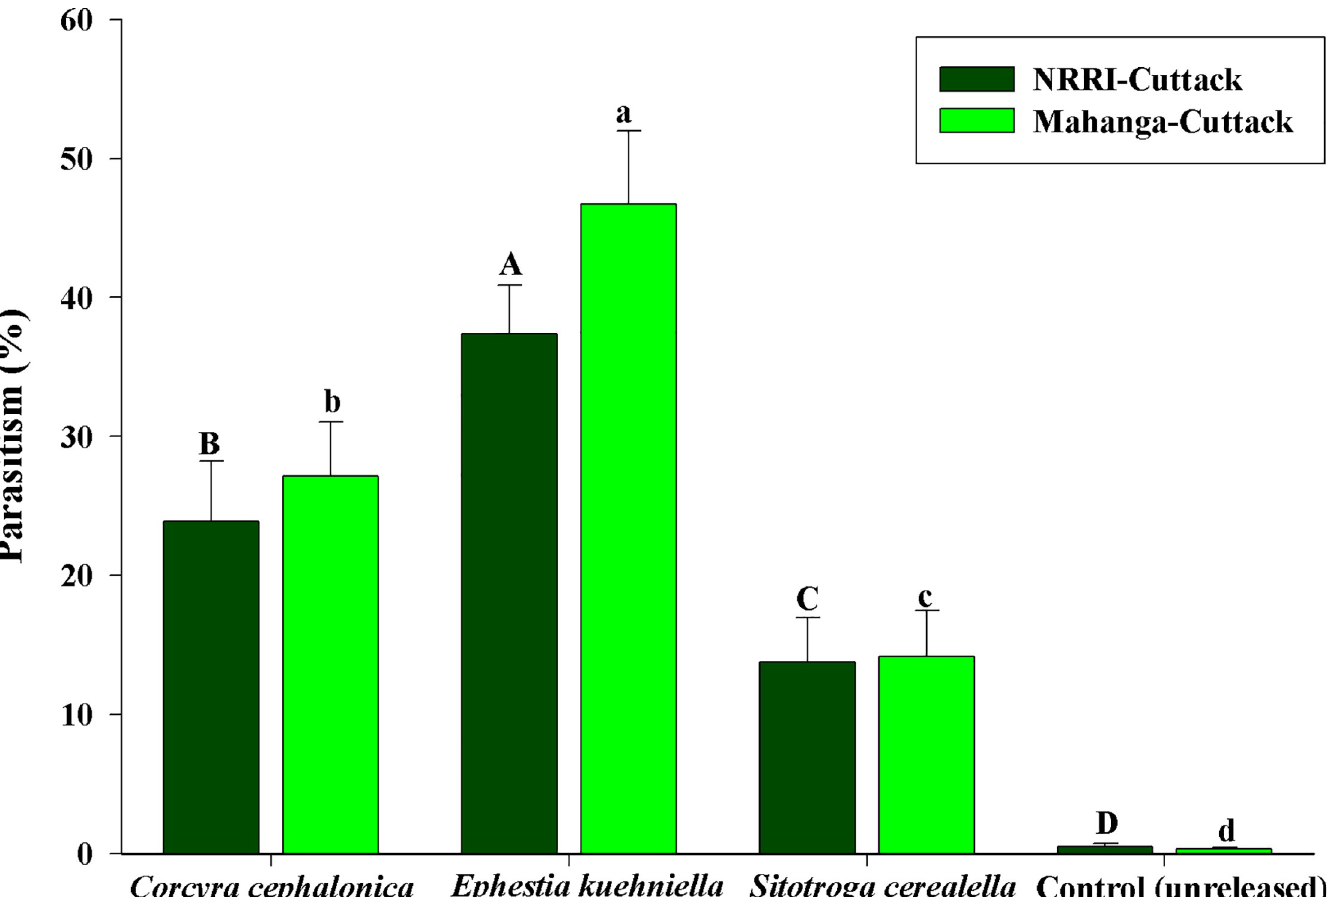
Fig 2. Parasitism of yellow stem borer (YSB) eggs by Trichogramma japonicum under field conditions when parasitoid reared on different factitious hosts. Multi- location field studies were conducted at NRRI, Cuttack and Mahanga, Cuttack. The values are presented as the mean ± standard errors. Treatments were compared using one-way ANOVA (Tukey’s HSD test, P < 0.01). The same letter above error bars (capital letters for NRRI, Cuttack location, lowercase letters for Mahanga, Cuttack location) did not differ significantly ( P � 0.01).